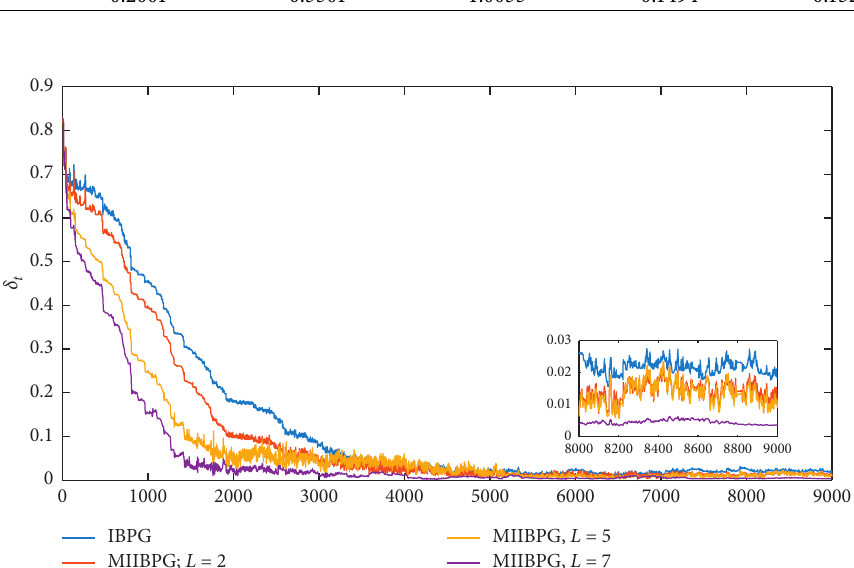
Figure 7: Evolution curves of parametric error for the FSOEAHW model using MIIBPG algorithm.